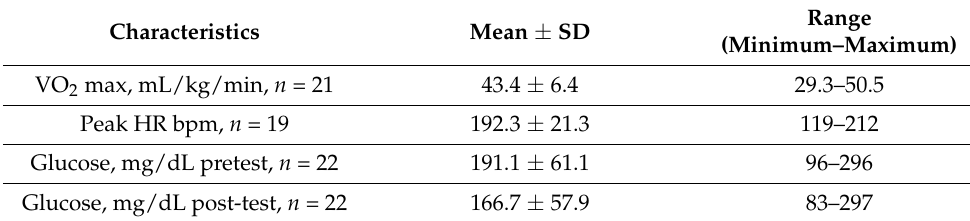
Table 2. VO 2 max testing measurements, N =